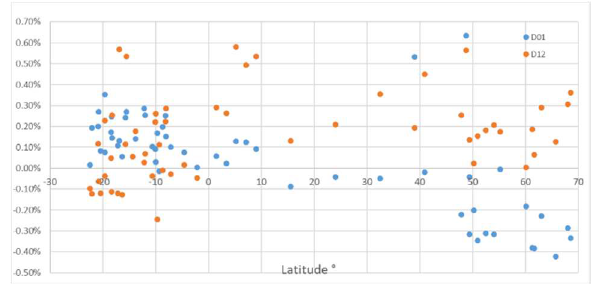
Figure 15 : Variation of V ground / V ground_nadir with latitude for center of extreme detectors D01 (blue) and D12 (orange). The opposite linear trends are due to the yaw drift which depends on latitude.